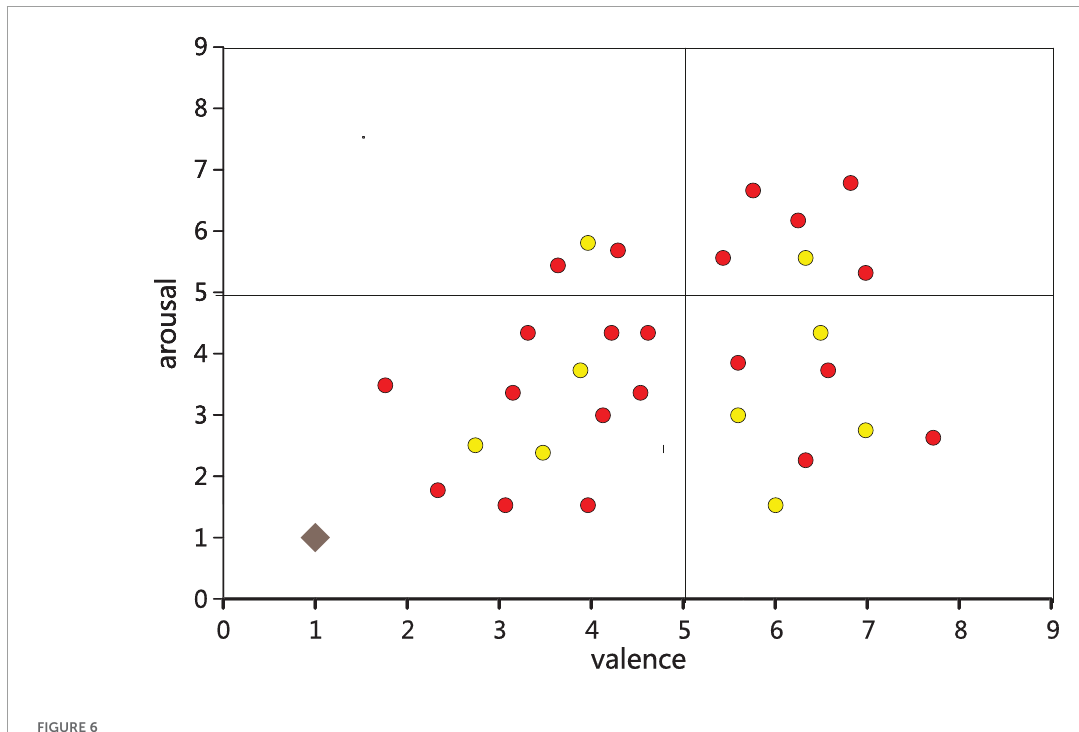
FIGURE5 Schematic diagram of EEG data acquisition equipment.